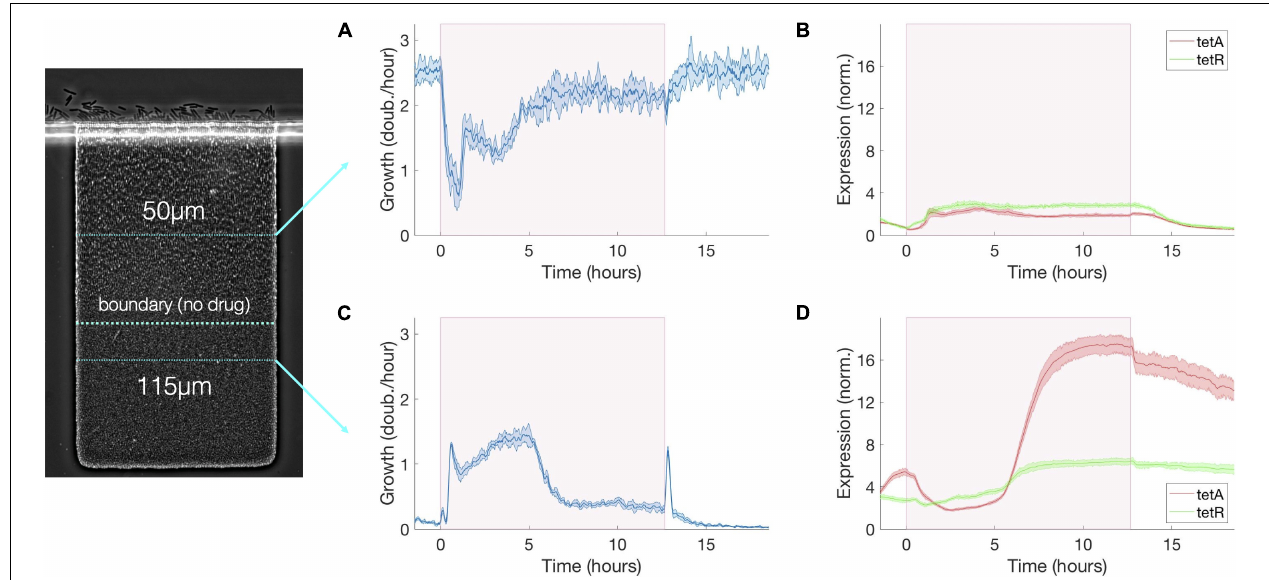
FIGURE 3 | Transient growth in the interior of the colony during drug exposure induces high levels of resistance. (A) Cell growth, (B) TetA and TetR expression at a fixed depth of 50 µ m during exposure to tetracycline. Cell growth decreases upon exposure but is mostly recovered after 5 h. TetA and TetR expression increase during exposure but return to pre-exposure levels after drug is removed. (C) Cell growth, (D) TetA and TetR expression at a fixed depth of 115 µ m during exposure to tetracycline. Transient increase in cell growth at lower depths corresponds to the period of reduced growth at the top of the trap. TetA and TetR expression increase substantially during exposure, and high expression levels are kept even after removal of the drug, when these cells become dormant. The period of exposure to tetracycline is depicted in pink shading. Shaded areas around the curves denote one standard deviation from the